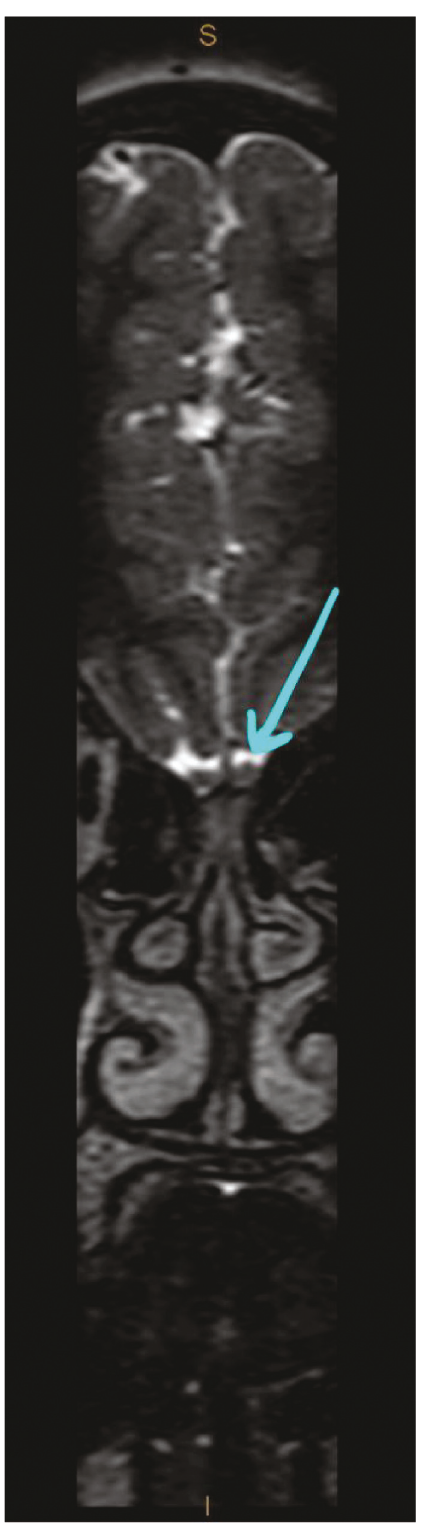
Figure 2: Coronal view of the MRI brain with olfactory protocol showing normal volume of olfactory bulbs (blue